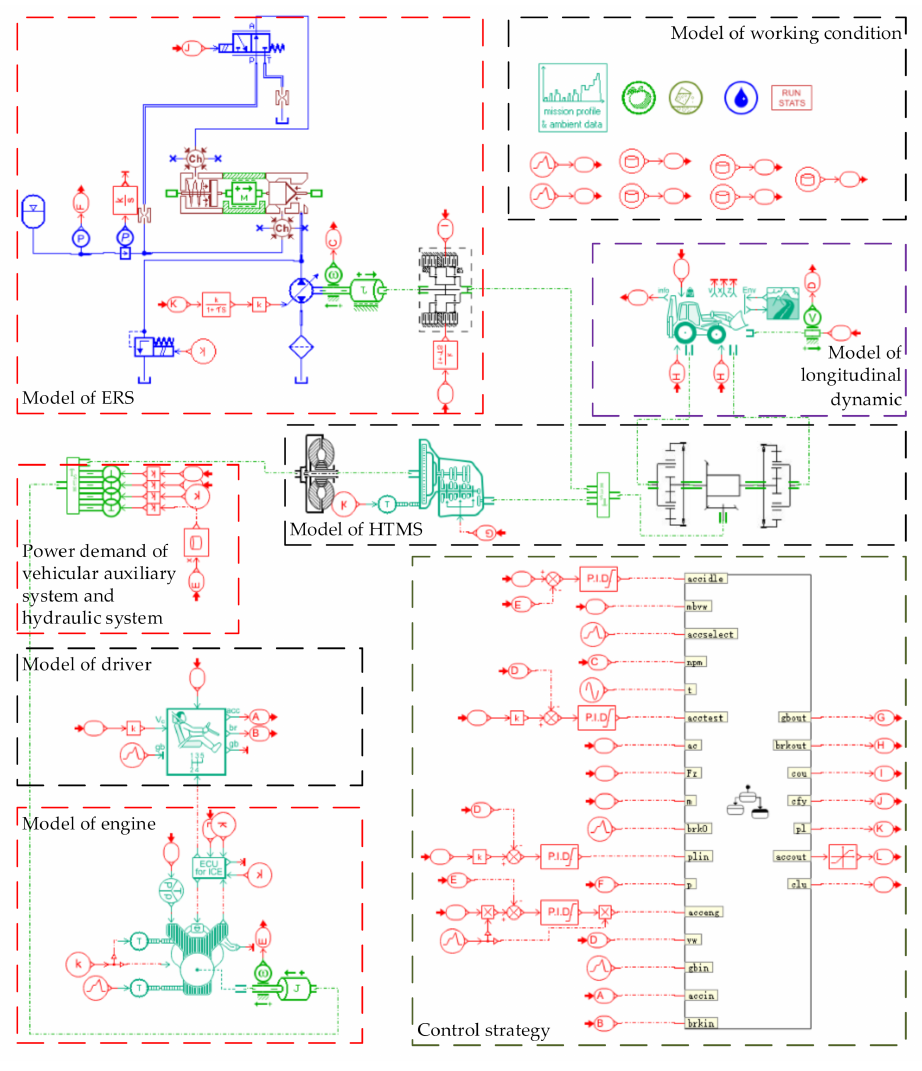
Figure 3. Final model of the